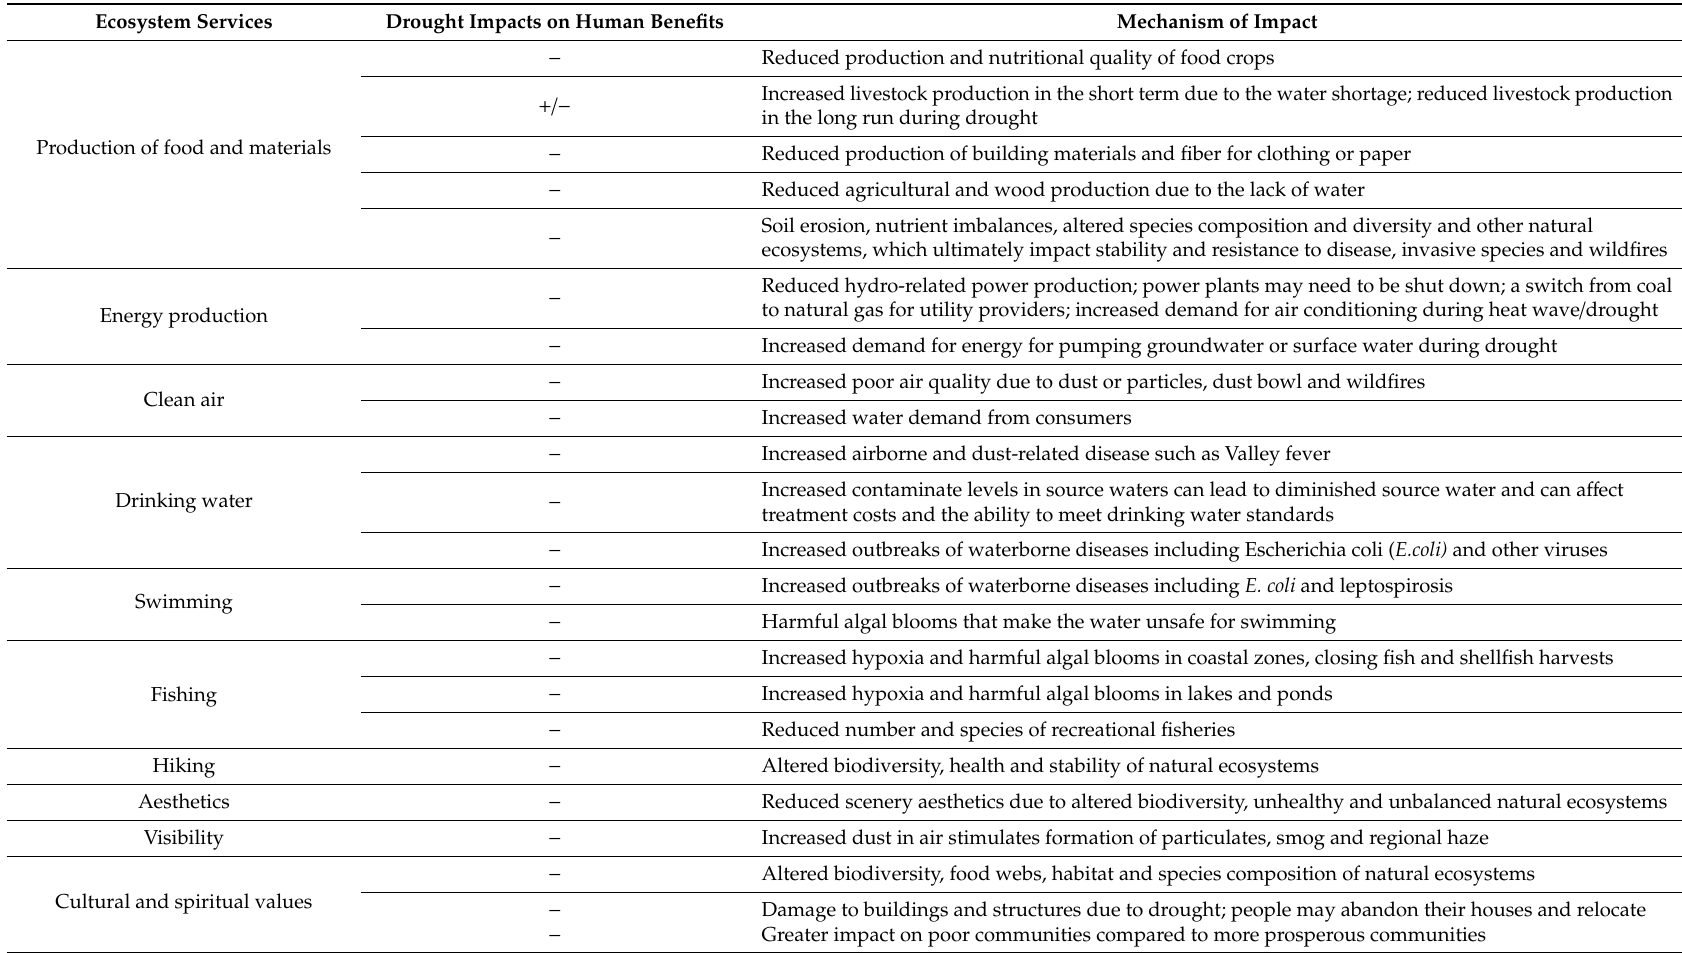
Table 2. Ecosystem services and human benefits a ff ected by drought (adapted from Compton et al.